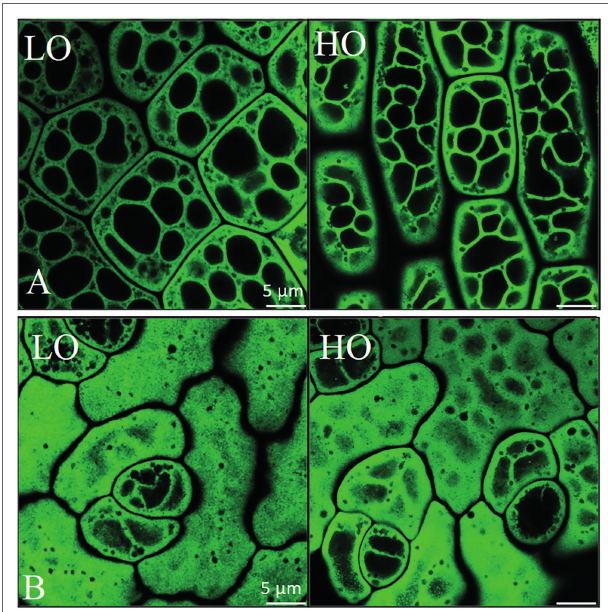
FIGURE 6 | Airyscan imaging of lipid droplets in embryonic axis (A) and cotyledonary (B) tissue in mature HO and LO pennycress embryos. Scale is 5 μ m. Mature seeds were imaged after staining of lipid droplets with BODIPY 493/503 (Invitrogen, Carlsbad, CA). Micrographs of dry seeds were acquired with a Zeiss LSM710 microscope fitted with Airyscan confocal superresolution and the MBS 488 beam splitter using an Apochromat 63×/1.4 oil DIC objective lens (Carl Zeiss Inc., Thornwood, NY). Excitation and emission signals of the BODIPY-stained lipid droplets were collected as single optical section images (z-sections) of cotyledons and embryonic axis cells. Airyscan images were processed using Zeiss Zen Blue